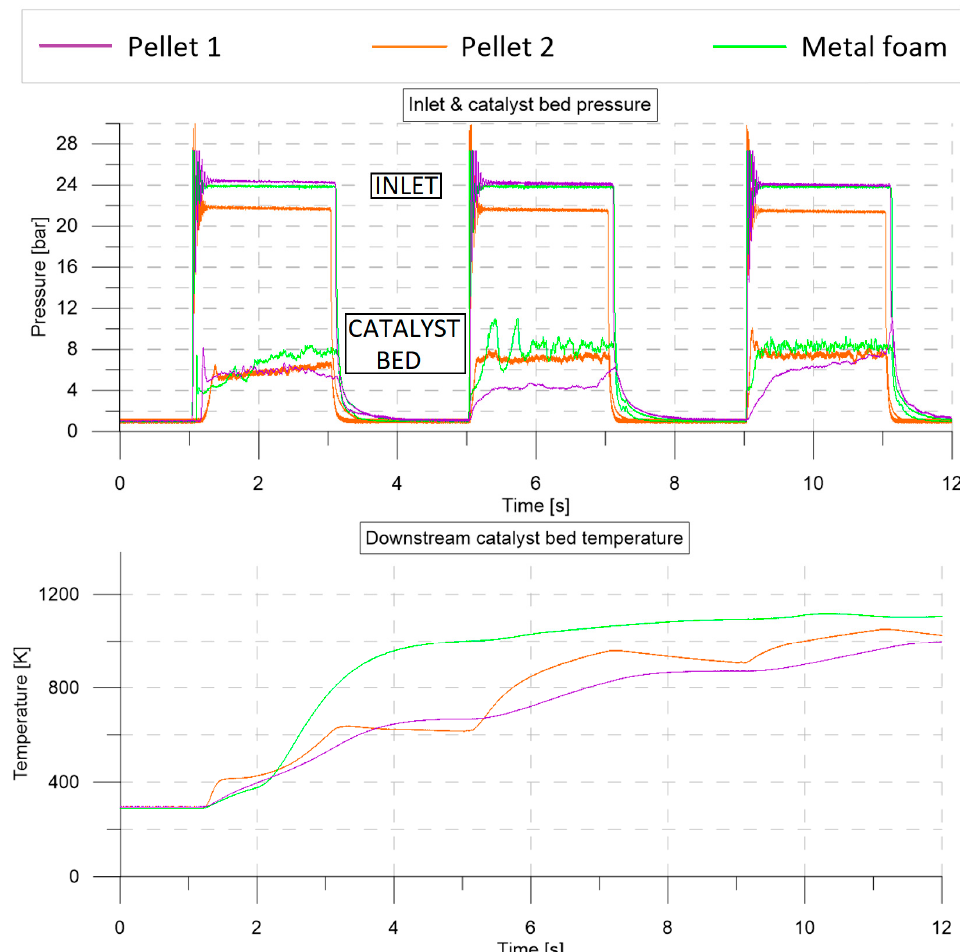
Figure 12. Comparison of results collected during experimental campaigns with three different cat- alysts.